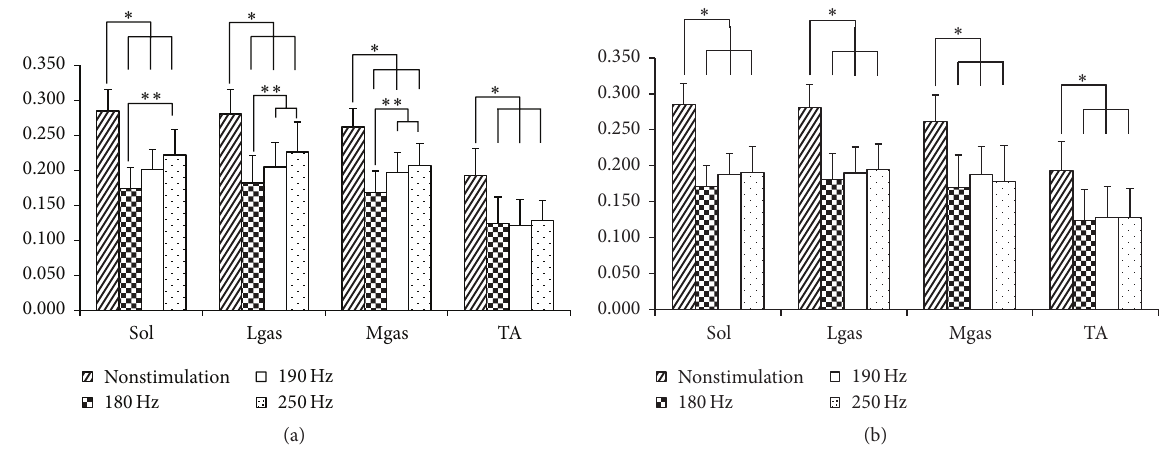
Figure 3: The muscle reaction time by the vibration stimulation applied on the Achilles tendon and tibialis anterior tendon according to vibration frequency [Sec] ( ∗ 𝑝 < 0.05 . nonstimulation versus other frequencies, ∗∗ 𝑝 < 0.05 . 180 Hz versus other frequencies). (a) Achilles tendon. (b) Tibialis anterior tendon. Table5:Themusclereactiontimeaccordingtotheintensityofvibration,perceptionthreshold(100%)andsubthreshold(80%)ontheAchilles tendon [Sec]. Lower leg muscles Soleus Lateral Gastrocnemius Medial Gastrocnemius